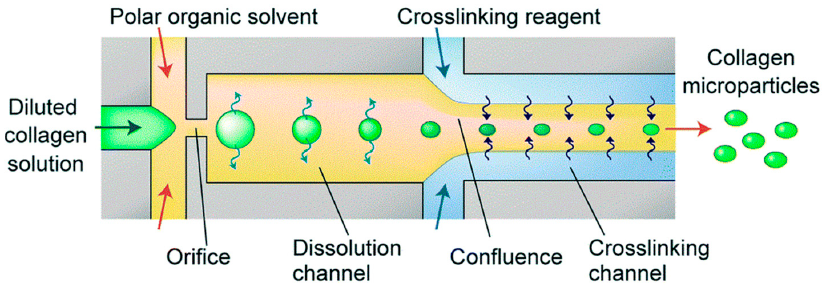
Figure 3. Microfluidic schematic for producing collagen microparticles. (Reproduced with permission from Reference [73], The Royal Society of Chemistry).